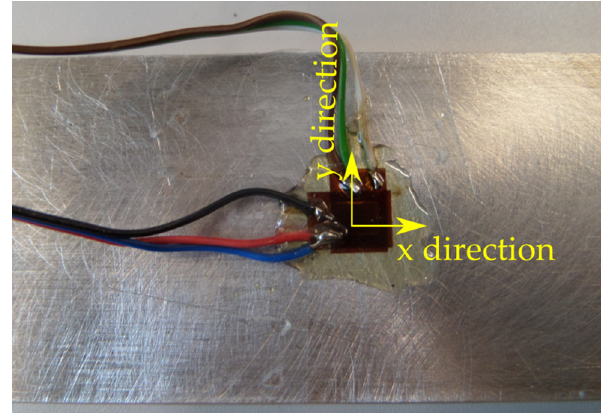
Table 3. Technological parameters corresponding to individual milling strategies.